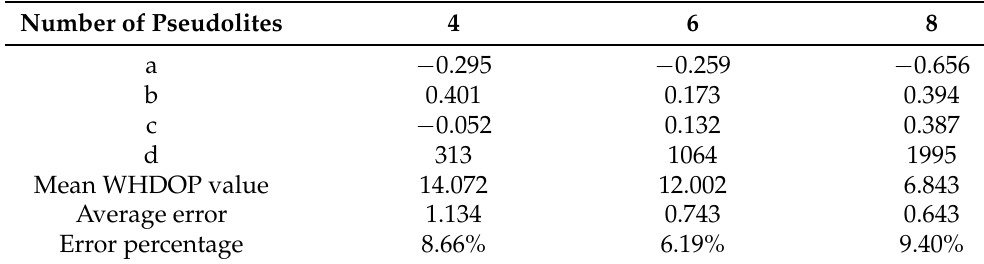
Table 1. Fitting parameters and errors under different numbers of